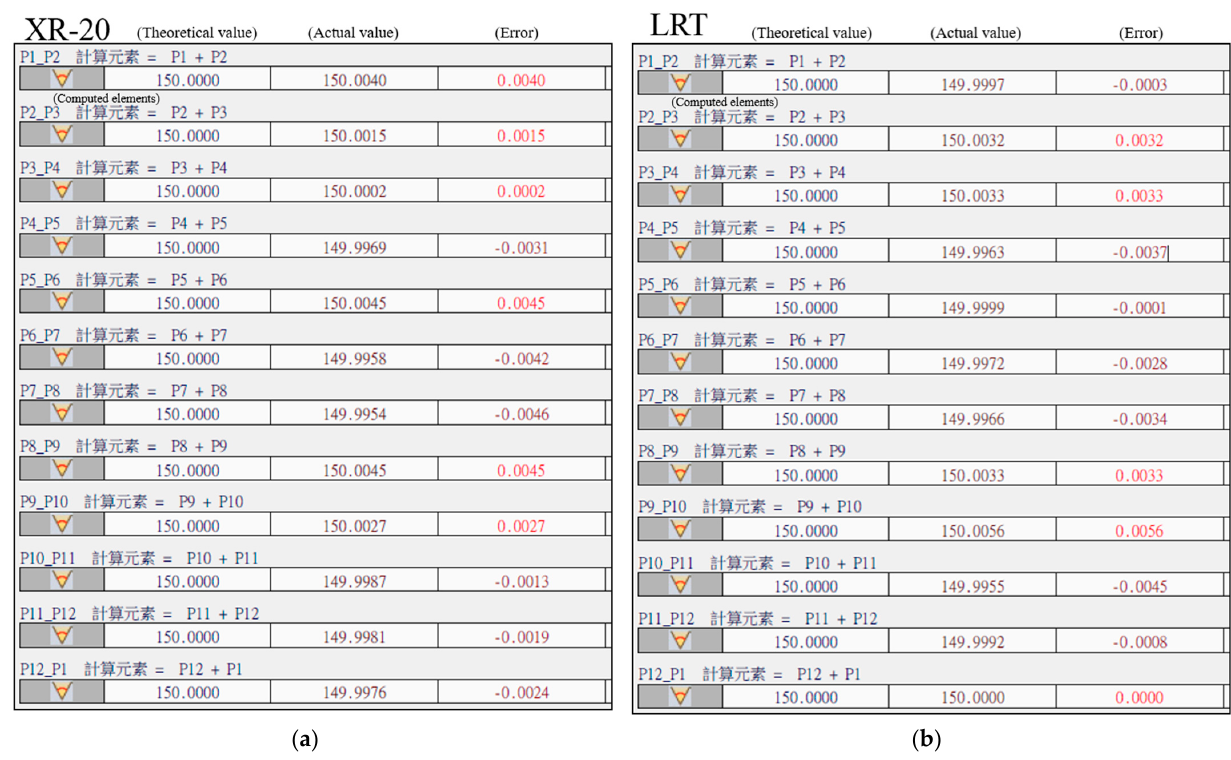
Figure 28. Comparison of the error result between two systems.